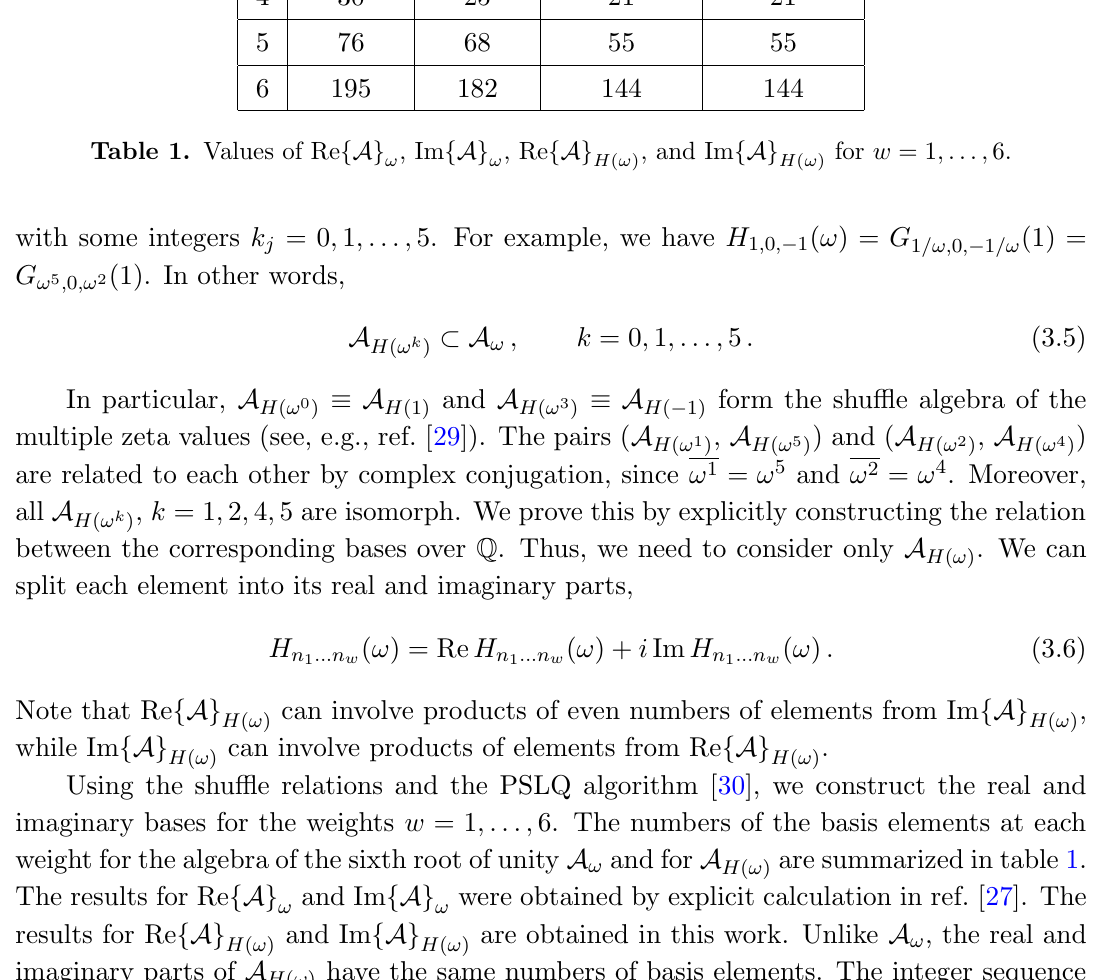
Table 1. Values of Re fAg